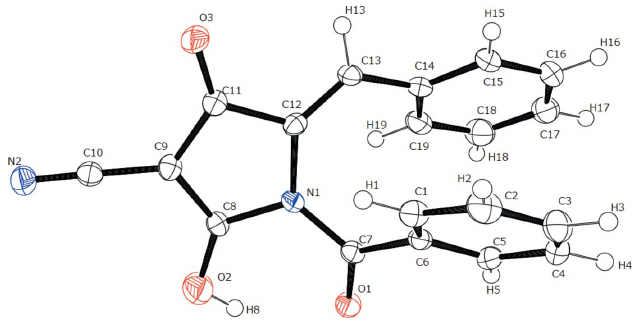
Figure 1 The title compound with 50% probability ellipsoids for non-hydrogen